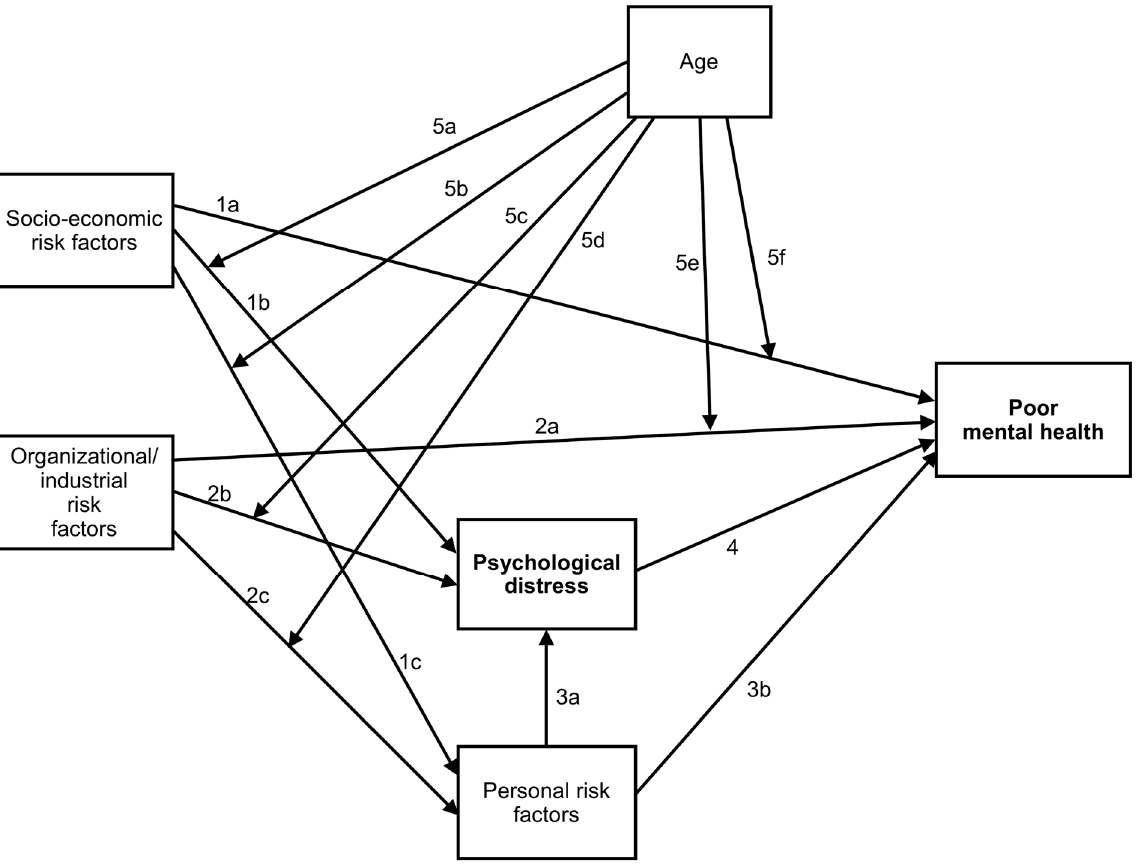
Figure 3. Conceptual model of the relationships between domains of psychosocial risk factors, psy- chological distress, and poor mental health in young construction workers.